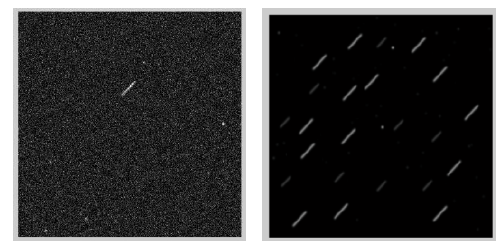
Figure 9. The simulated images in SSM (left) and TRM (right) To evaluate the performance of the algorithms, the noise was added to the images. The image noise group contains shot